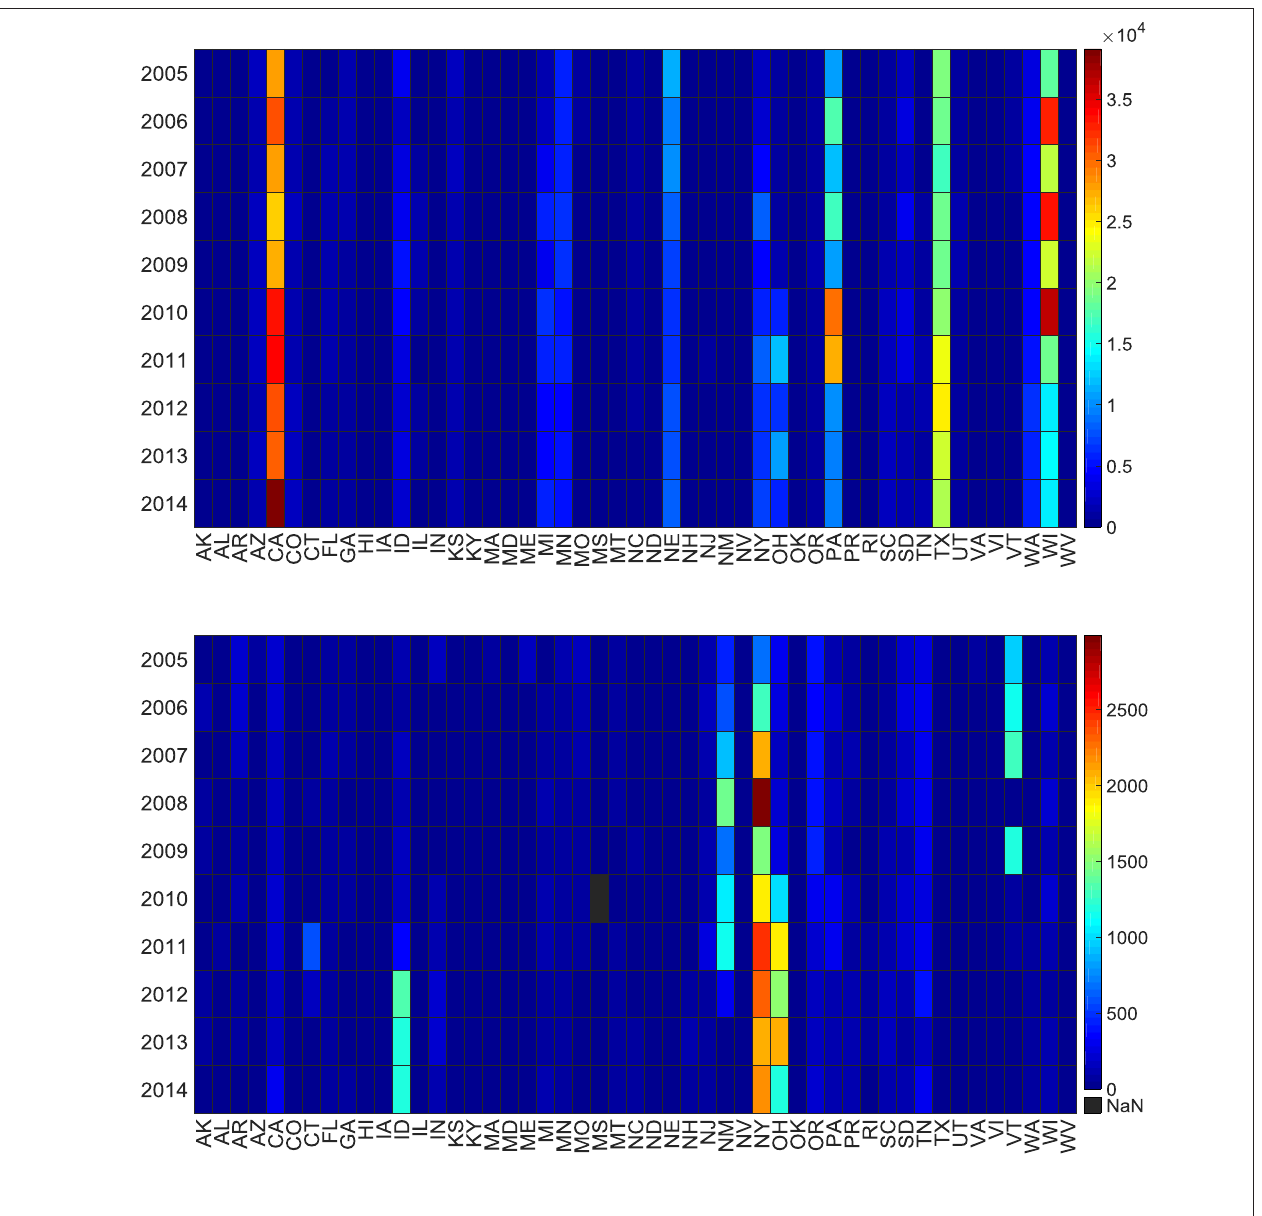
FigUre 3 | Number (top) and rate (bottom) of cattle carcasses condemned per state and per year in the US. The rate is in 10,000 cattle